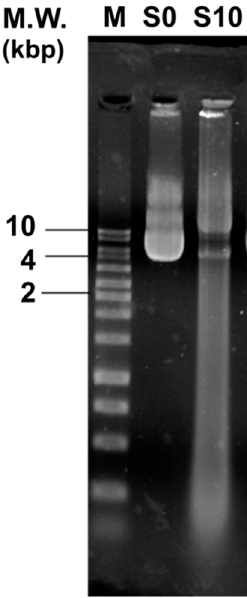
Figure 7. S10 CAPJ induces DNA double-strand breaks (DSB). The pGL3 (2 μ g/ μ L) was untreated (S0) or treated with S10 CAPJ. The plasmid DNA was loaded on 1.0% agarose gel for electrophoresis. Ethidium bromide-stained DNA was visualized under UV light. The positions of the size markers are shown at left of the image. M, DNA marker.